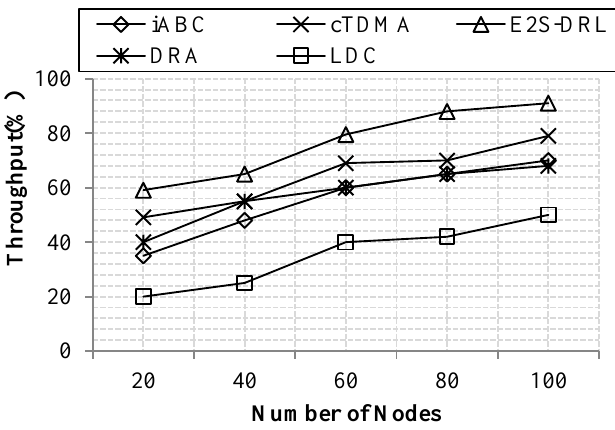
Figure 8. Comparison of throughput.